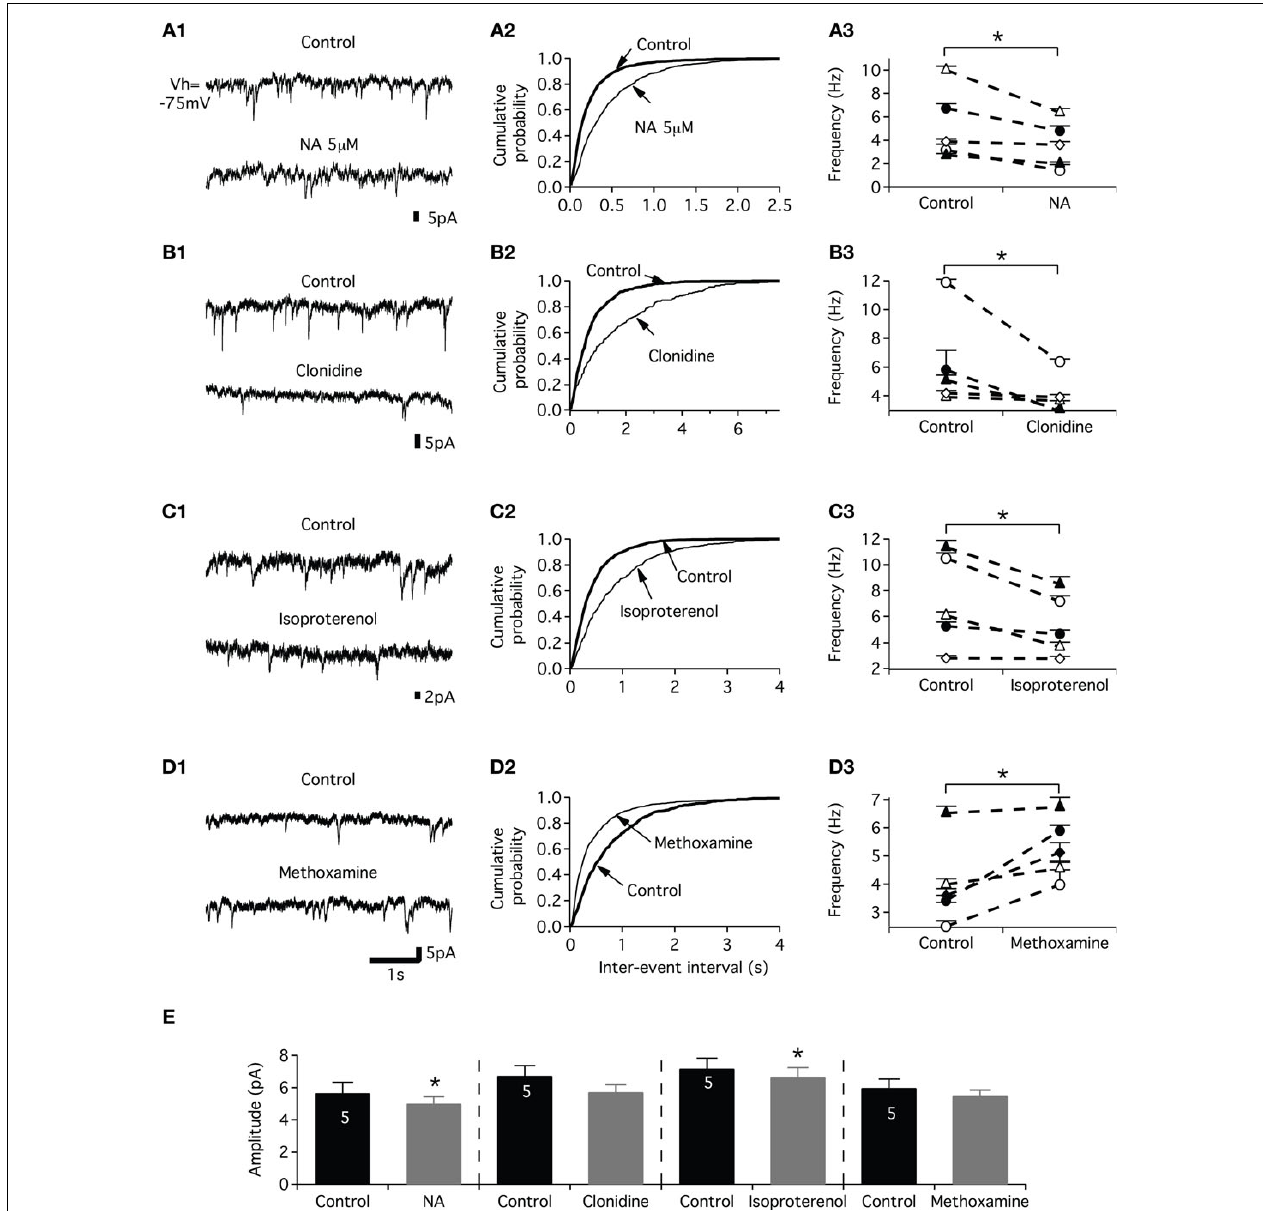
mEPSCs in each neuron of the sample (A3) . (B,C,D) As for (A) but in the presence of clonidine (B) , isoproterenol (C) and methoxamine (D) . (E) Summary histogram of the mean amplitude of the mEPSCs in control conditions (black bars) and in the presence of the various NAergic agents (grey